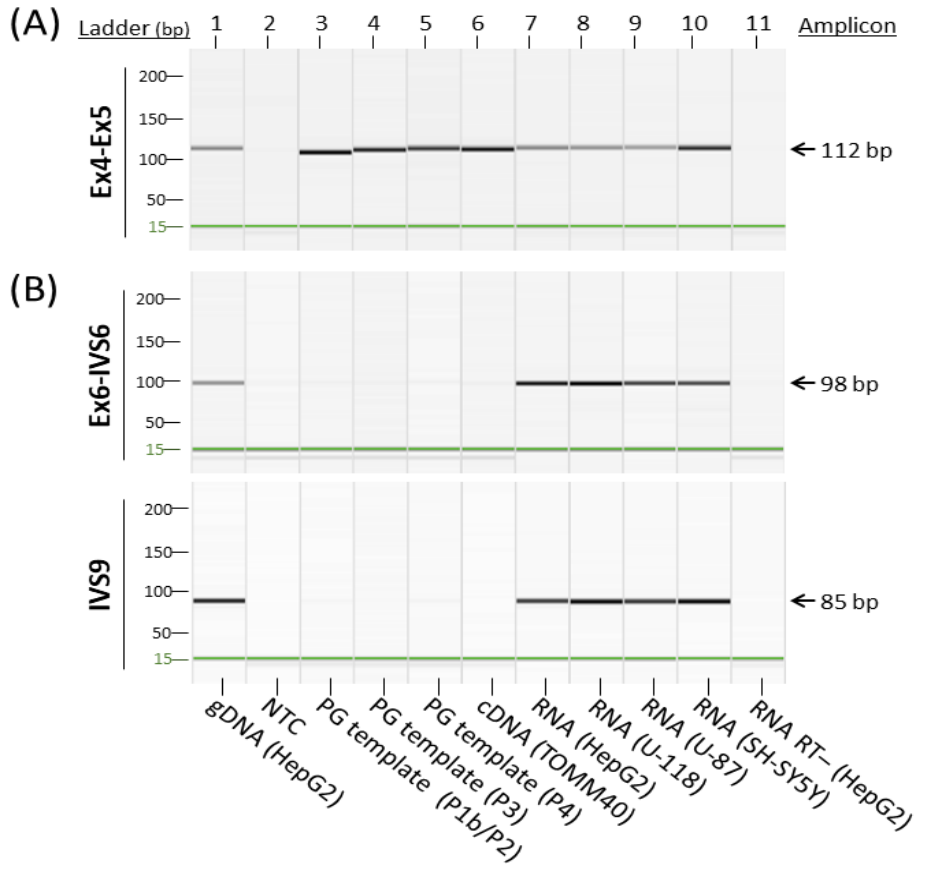
Figure 3. Comparison between a conventional cDNA assay and primary transcript-targeted cDNA assays. Capillary gel electrophoresis images of the RT-PCR amplified TOMM40 pseudogene ampli-